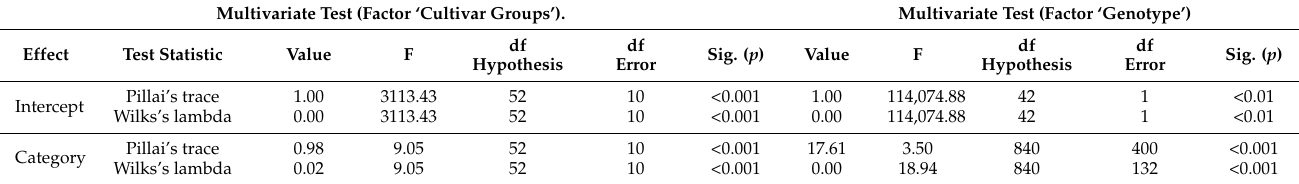
Table 2. MANOVA analysis considering as ‘factor’ the cultivar typology (‘Peperone Cornetto di Pontecorvo’, CP; and ‘Similar horn types’) and the 21 studied accessions (factor = genotype). Multivariate Test (Factor ‘Cultivar Groups’).